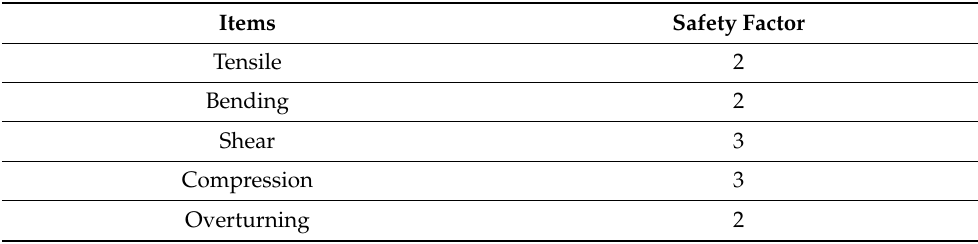
Table 10. Safety factor of scaffold and safety facility